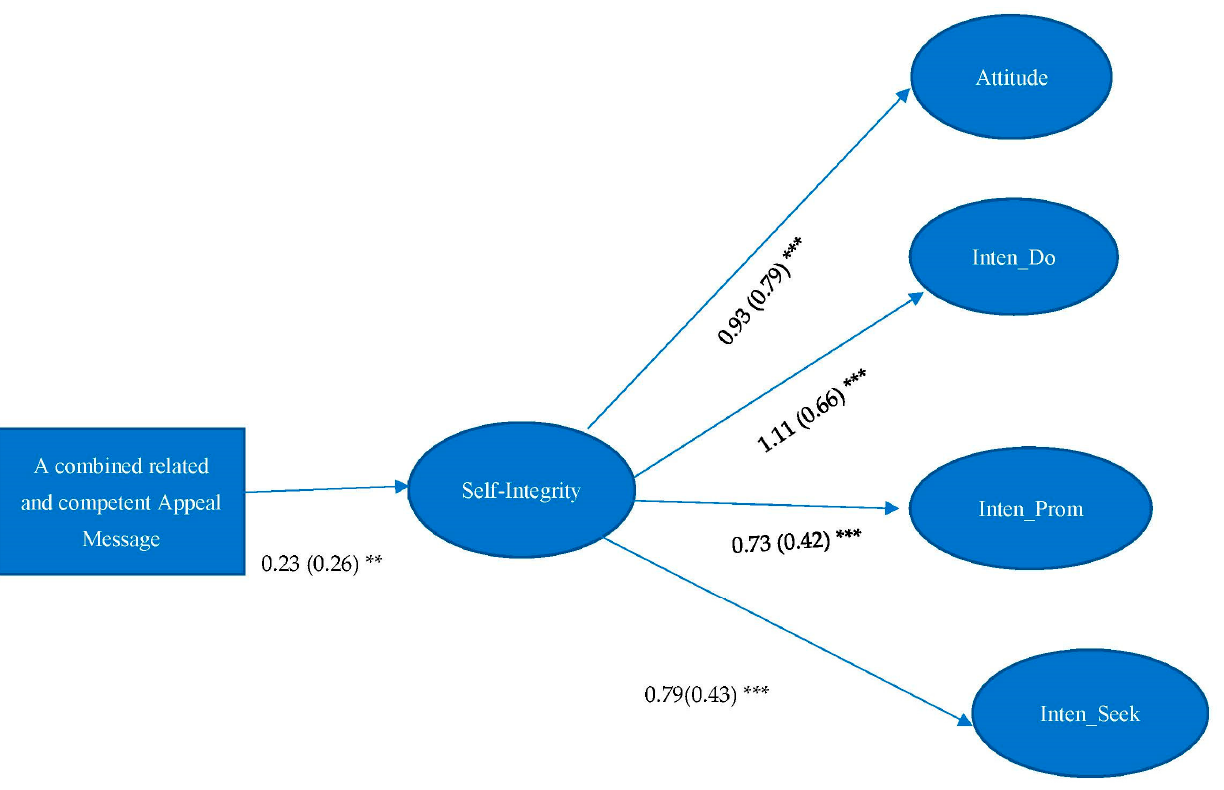
Figure 2. Unstandardized estimates are listed, followed by standardized estimates in parentheses. Model Fit: χ 2 = 449.147, df = 224, p < 0.001; RMSEA < 0.001, 90% C.I.: 0.064–0.084, CFI = 0.920, SRMR